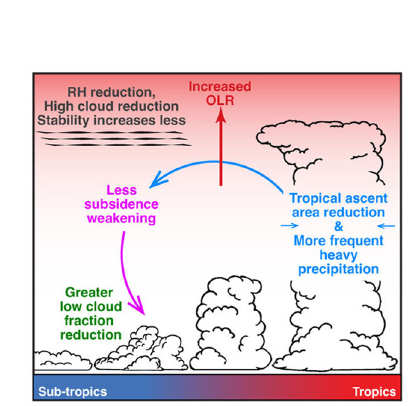
shown in blue, whereas the Stability-Subsidence Pathway is shown in orange. The direction of the arrows signi fi es suggested pathways of causality. Red values are Pearson correlation coef fi cients. All correlations are statistically signi fi cant at the 95% con fi dence